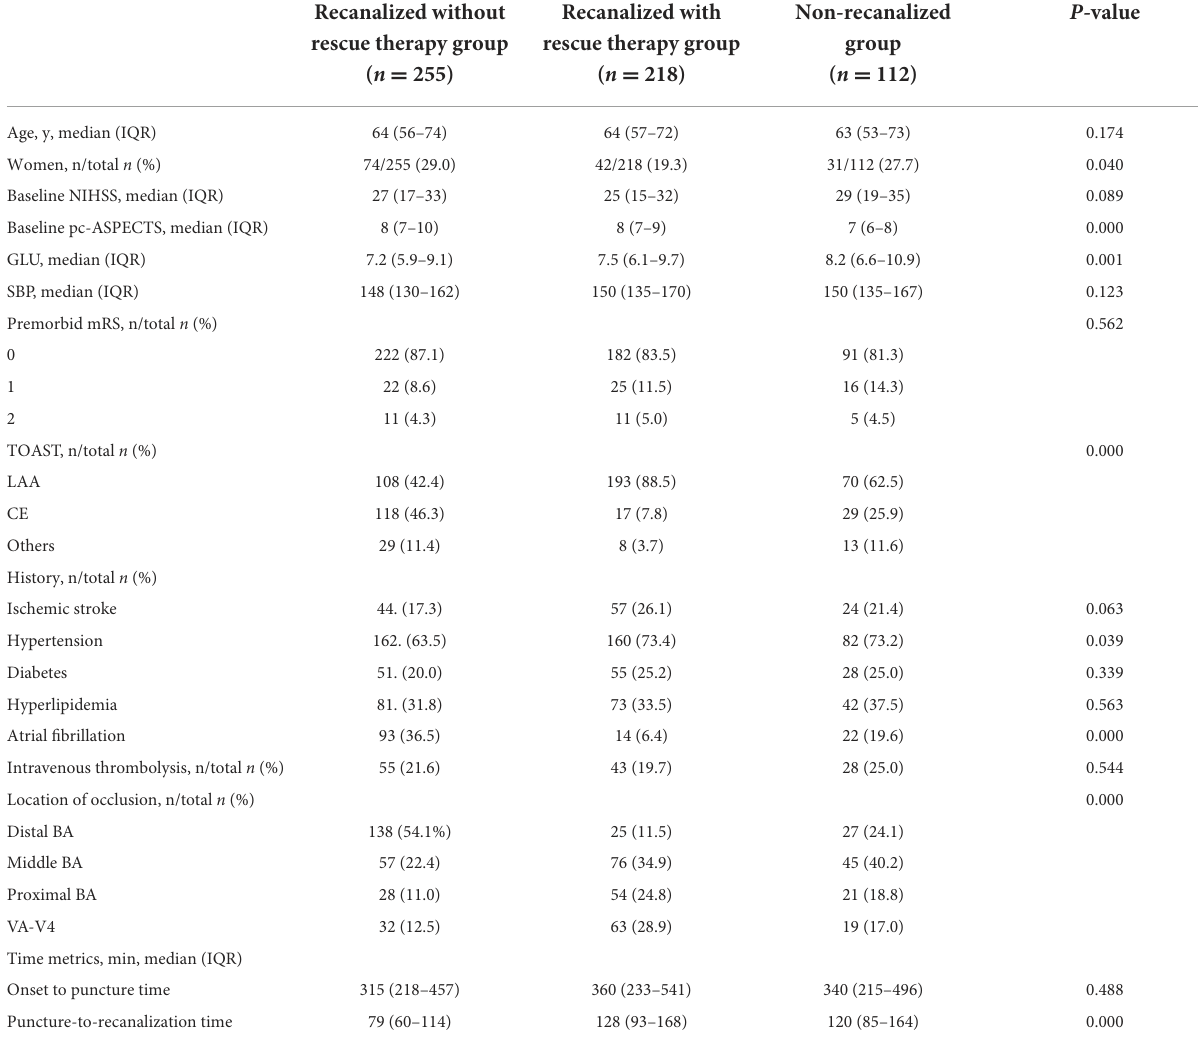
TABLE 1 Baseline characteristics of the patients treated with endovascular thrombectomy in the recanalized with or without rescue therapy and the non-recanalized groups. Recanalized without Recanalized rescue therapy group ( n = 255)